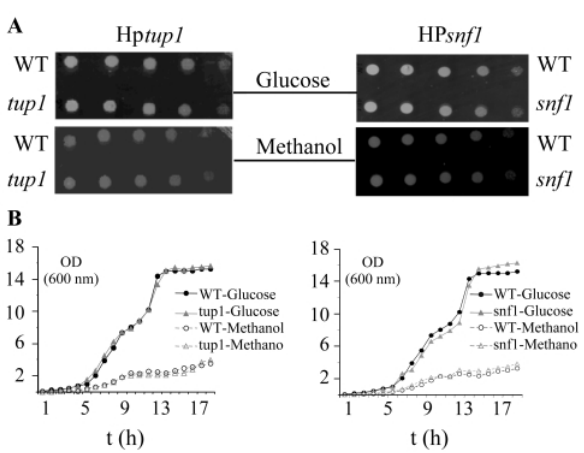
Figure 4 - Effects of tup1 and snf1 deletions on growth on glucose and methanol. A: Patch growth assays were performed with wild-type, swi2 and swi3 cells in agar plates containing 5% glucose or 1% methanol (Verdoucq et al ., 1999; Demasi et al ., 2001). Plates were photographed af- ter 48 h of incubation at 37 °C. B: Growth rates of WT, tup1 and snf1 strains on liquid media containing 5% glucose or 1% methanol were deter - mined by monitoring growth for up to 24 h. The results are the average of three independent